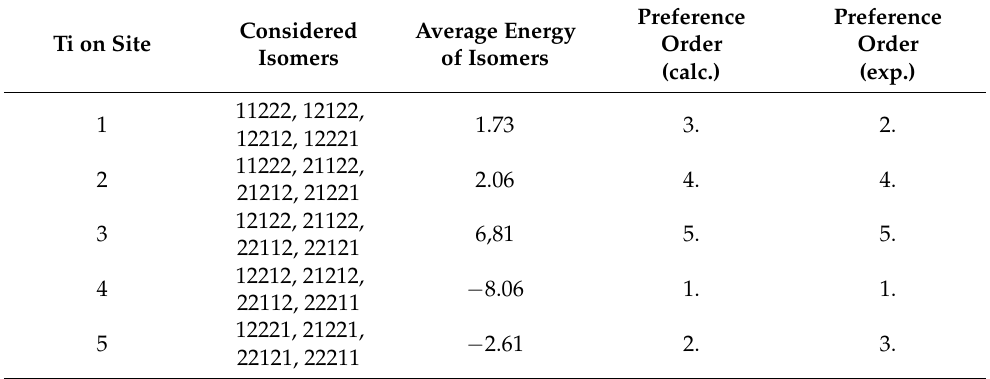
Table 5. Average energy of isomers with a given site occupied by titanium, together with the calculated and experimental order of Ti site preference. The isomers considered in the averaging are listed for each site. The relative energies refer to the calculations listed in the first row of Table 3. The experimental preference order is derived from Table